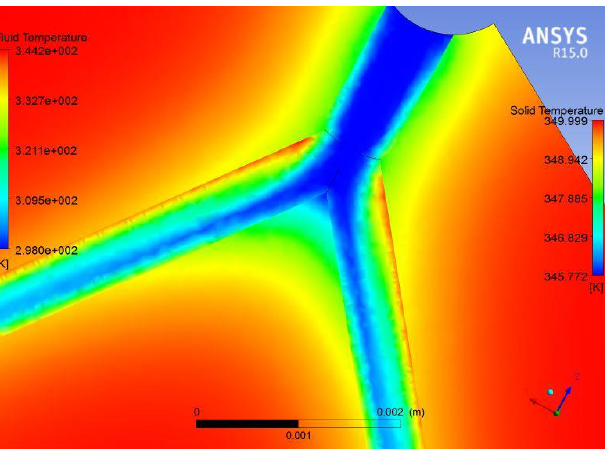
Figure 2. “Typical” CFD of a DSHE . Reprinted with permission from Ref. [12]. Copyright 2017 Elsevier.